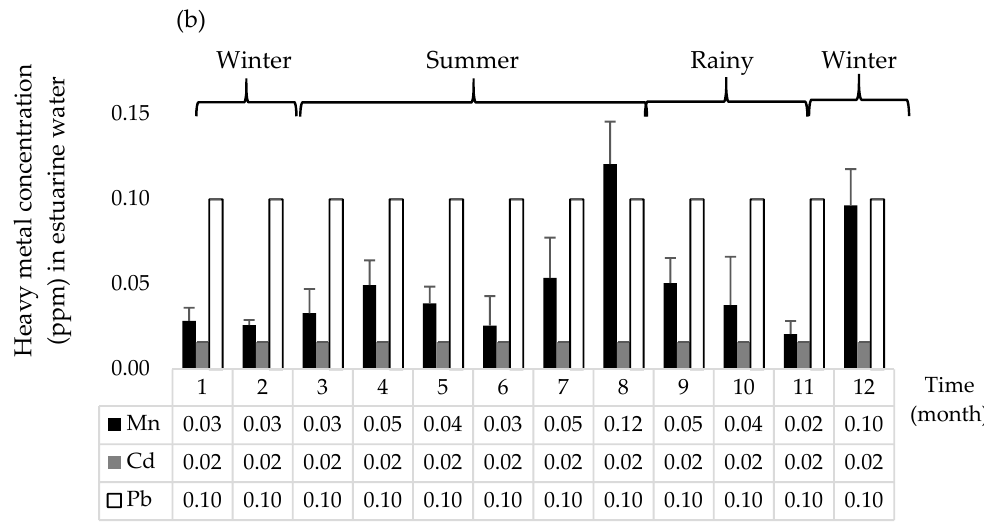
Figure 3. Heavy metal concentration (ppm) of manganese (Mn), cadmium (Cd), and lead (Pb): ( a ) oyster meat samples; ( b ) estuarine waters from Phang Nga Bay, southern Thailand. Samples were collected from March 2016 (month 1) to February 2017 (month 12).